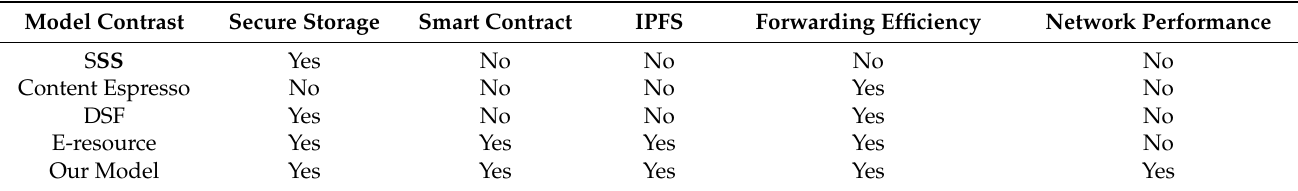
Table 2. Model performance